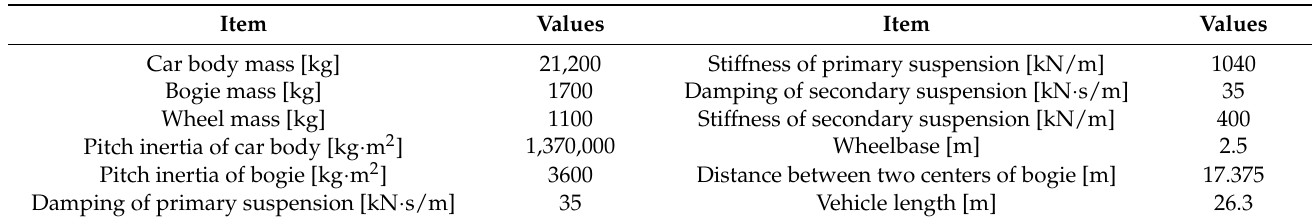
Table 1. The vehicle parameters of CRH3 train.